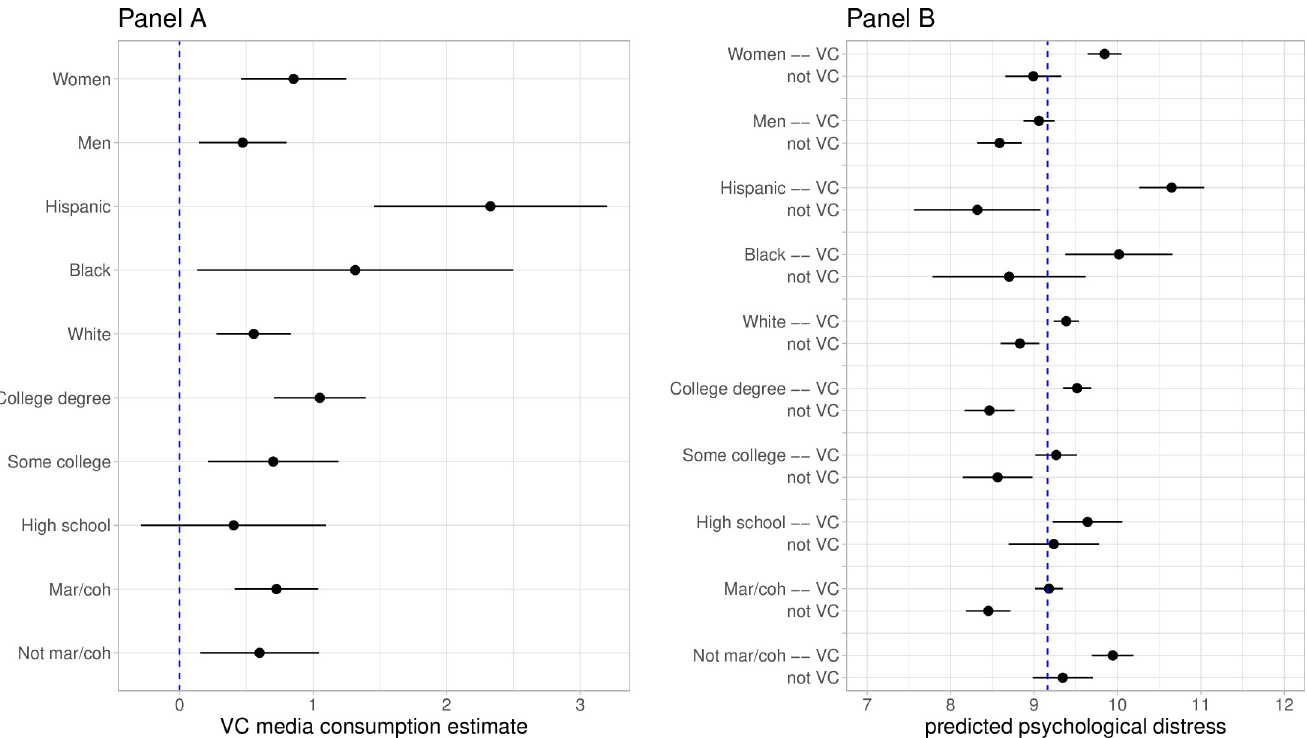
Fig 2. Estimates of coefficients (Panel A) and predicted values (Panel B) from regressing psychological distress on very close media consumption stratified by subsamples indicated on the y-axis. Estimates are unstandardized with 95 percent confidence intervals. All models are weighted and adjust for all covariates outlined in the text. VC = very close. Not VC = not very close. The dashed line in Panel A marks an estimate of 0 and the dashed line in Panel B marks the weighted average level of psychological distress among all respondents.